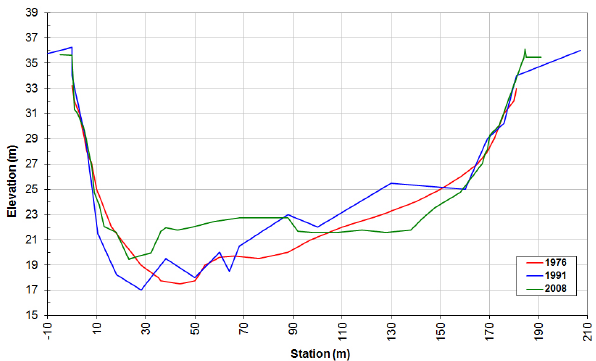
Fig. 9. Changing in geometry shape of Sarai Baghdad gauging sta- tion.